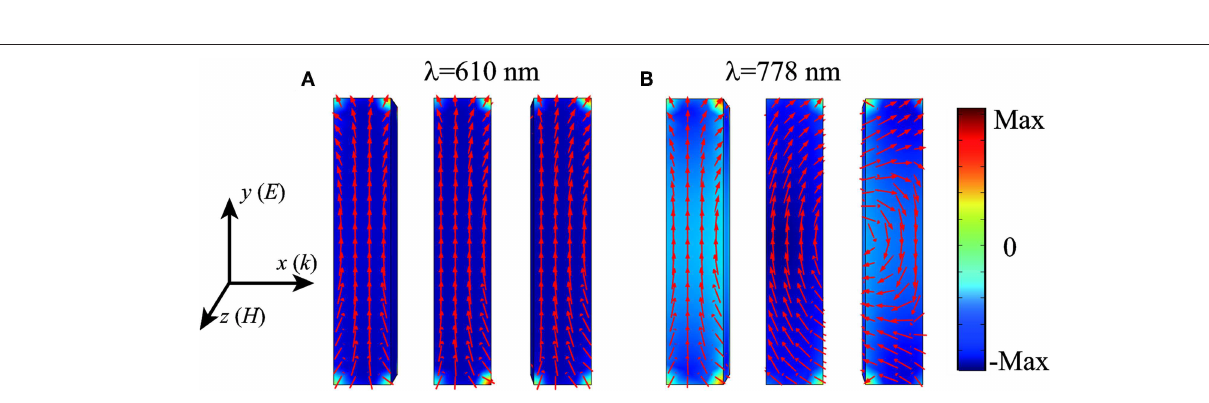
Frontiers in Physics | www.frontiersin.org